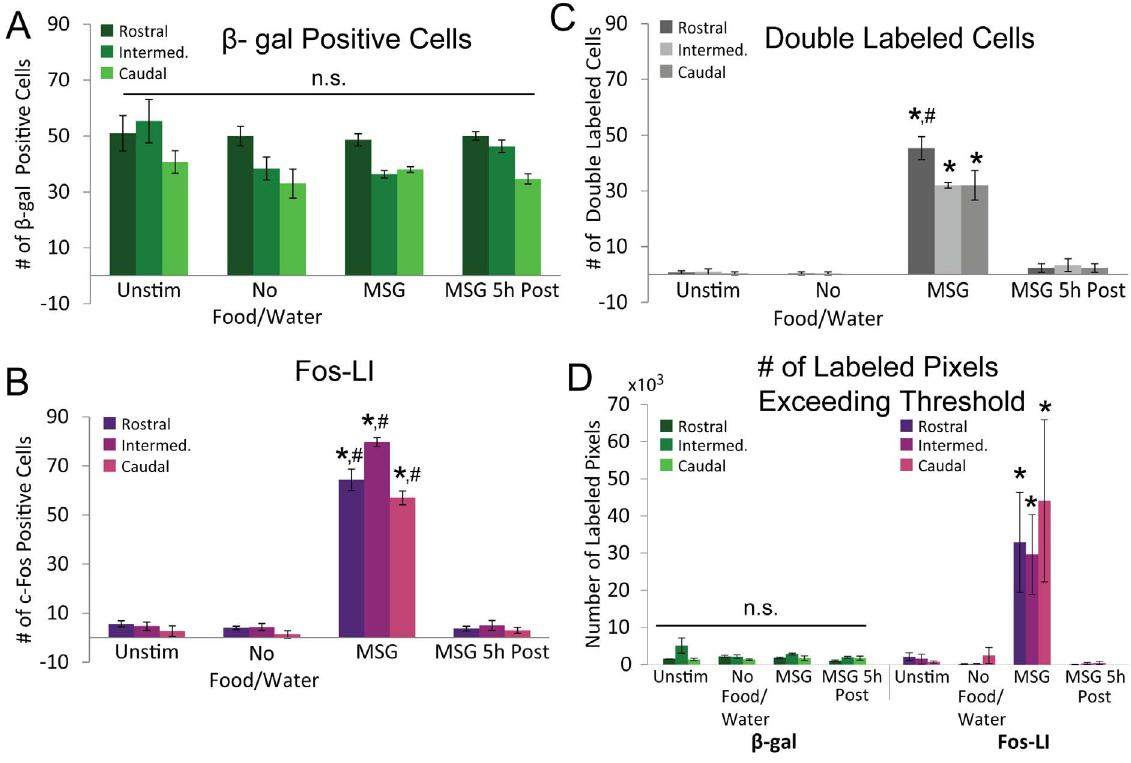
Figure 3. Bar graphs summarizing all quantative measurements across experimental conditions. A : The number of b -gal positive cells (green) was not different within each nTS level (Rostral, Intermediate, Caudal), nor between stimulation groups (Unstim, No Food/Water, MSG, MSG 5 h Post, p=0.25). Interestingly, the number of b -gal positive cells, irrespective of group, was significantly different between nTS levels (Rostral . Intermediate . Caudal; all p’s . 0.05, data not shown). B : In contrast to the number of b -gal positive cells, the number of c-Fos positive cells (Fos-LI; magenta) was significantly different between groups, with Fos-LI in the MSG group greater than all other groups. Also, within the nTS of the MSG group, Fos-LI was significantly different between nTS levels (Intermediate (Intermed.) . Rostral . Caudal). C : The number of c-Fos/ b -gal double labeled cells matched the Fos-LI results seen in C , with the number of double labeled cells significantly greater in the MSG group as compared to all other groups. Also, the number of double labeled cells was significantly greater in the Rostral level of the nTS in the MSG group compared to both the Intermed. and Caudal groups. D : The number of b -gal (green) labeled pixels that exceeded threshold (which includes both cell bodies and cellular processes) was not statistically different between groups (p=0.36). However, the number of c-Fos labeled pixels (magenta) was significantly greater in the MSG group as compared to all other groups. In all figures: n.s.=not statistically significantly different; *=a significant difference between the MSG group vs. all other groups; # =a significant different between nTS levels within the MSG group. All p’s , 0.05.